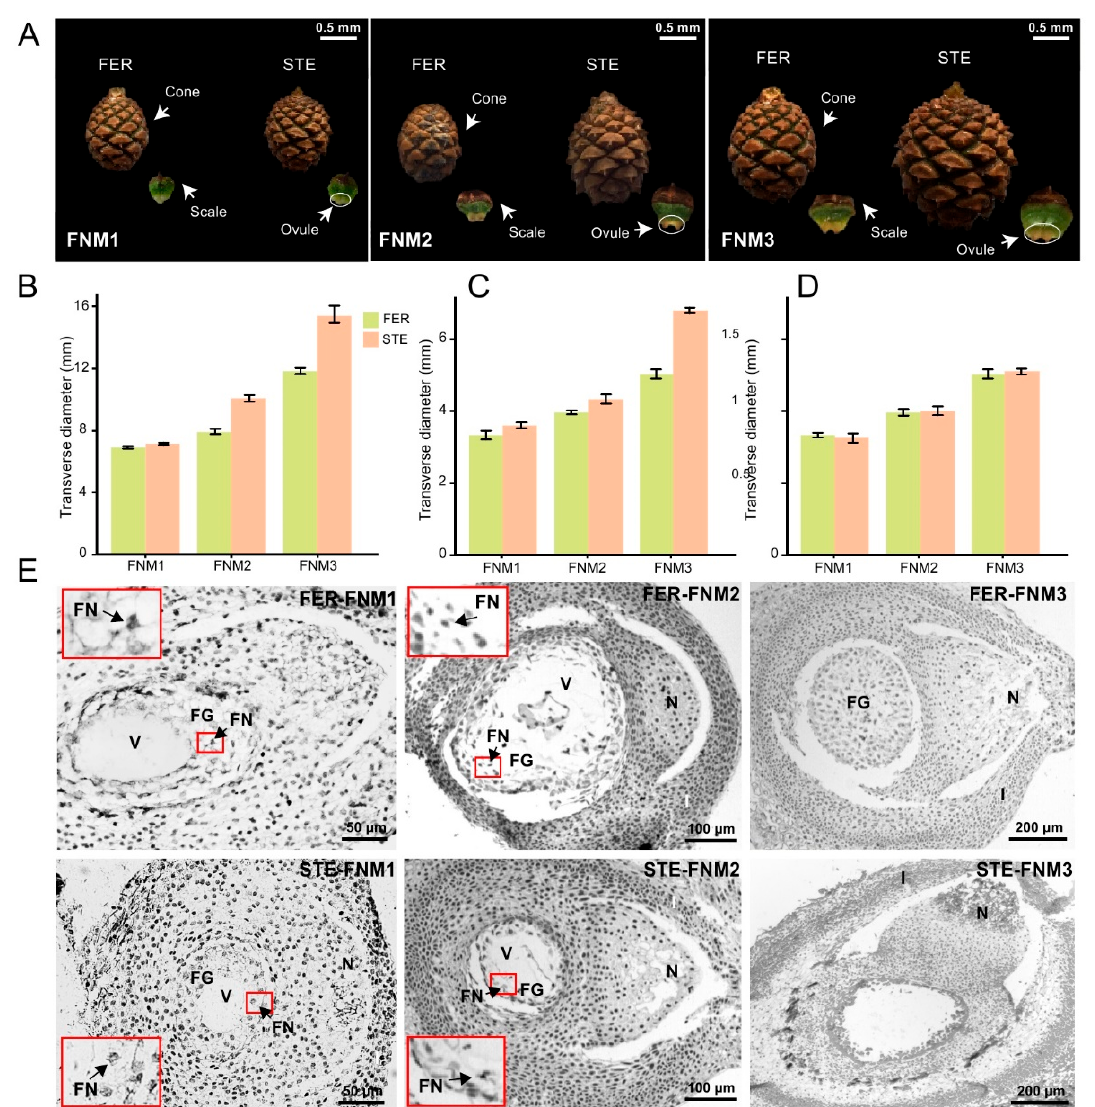
Figure 1. ( A ) Morphologic and microscopic observations of female fertile line (FER) and female sterile line (STE) ovules in Pinus tabuliformis. Cones and scales of different development stages. ( B – D ) The transverse diameters of cones, scales, and ovules in FER and STE. ( E ) The micrographs of ovules in different development. FG: female gametophyte; FN: free nucleus; I: integument; N: nucellus; V: vacuole.